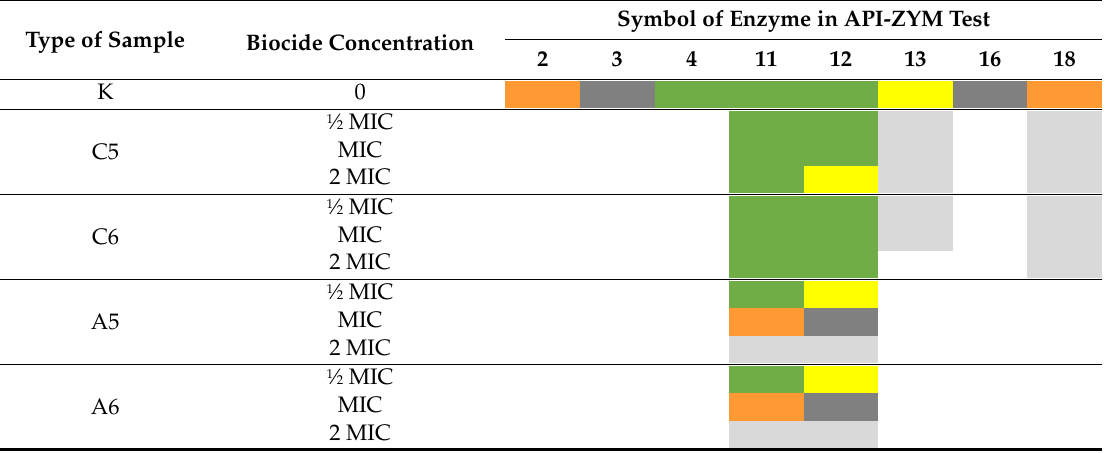
Table 1. Effect of cationic C6 or C5 and neutral A5 or A6 surfactants at 1 ⁄ 2 MIC, MIC, and 2 MIC on the enzymatic profile of Aspergillus brasiliensis